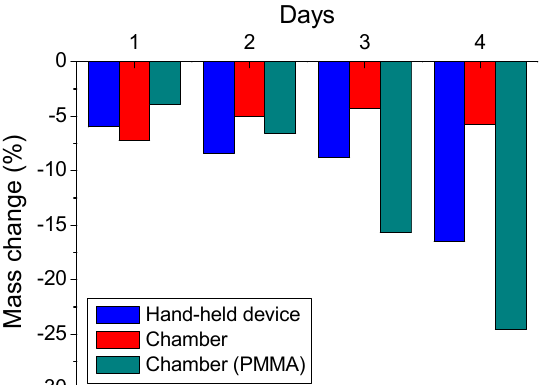
Figure 5. Mass changes of the coated concrete specimens after the application of HHD spraying test, as well as of the coated concrete and PMMA plates after the application of chamber spraying